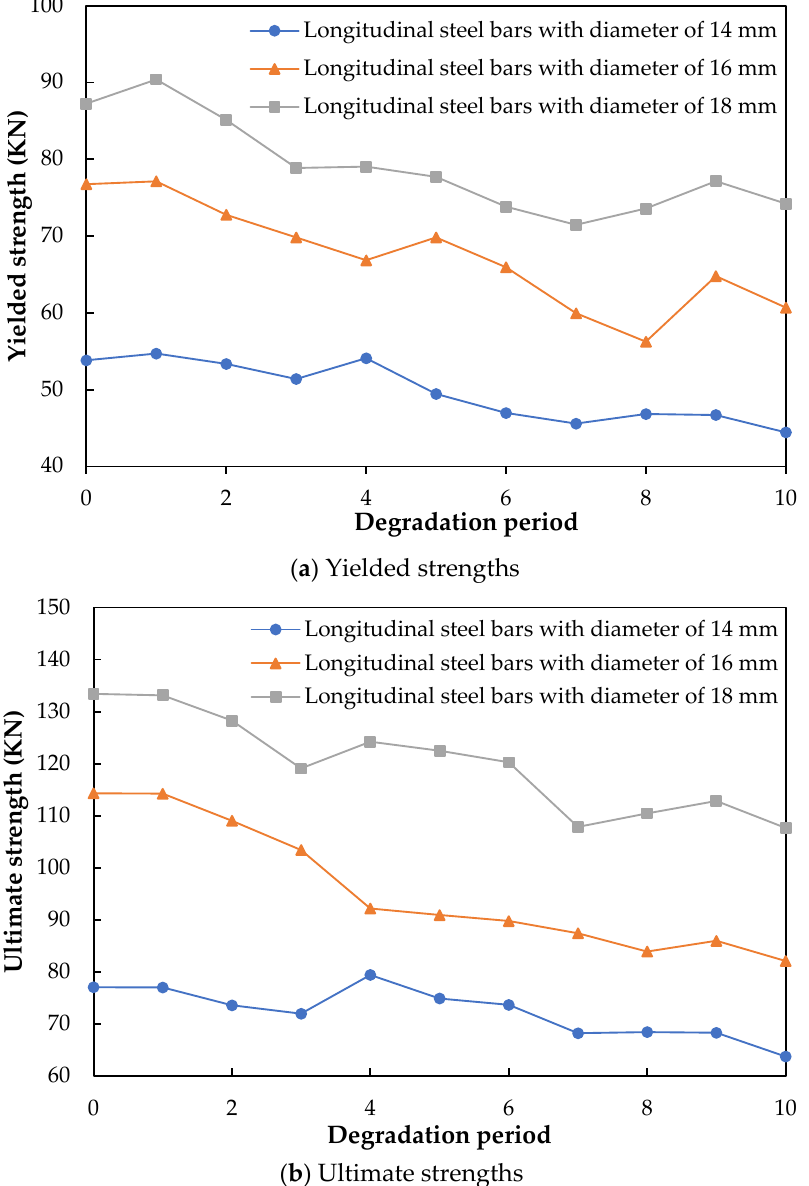
Figure 11. Tensile strengths of corroded longitudinal steel bars: ( a ) average yielded strengths and ( b ) average ultimate strengths.